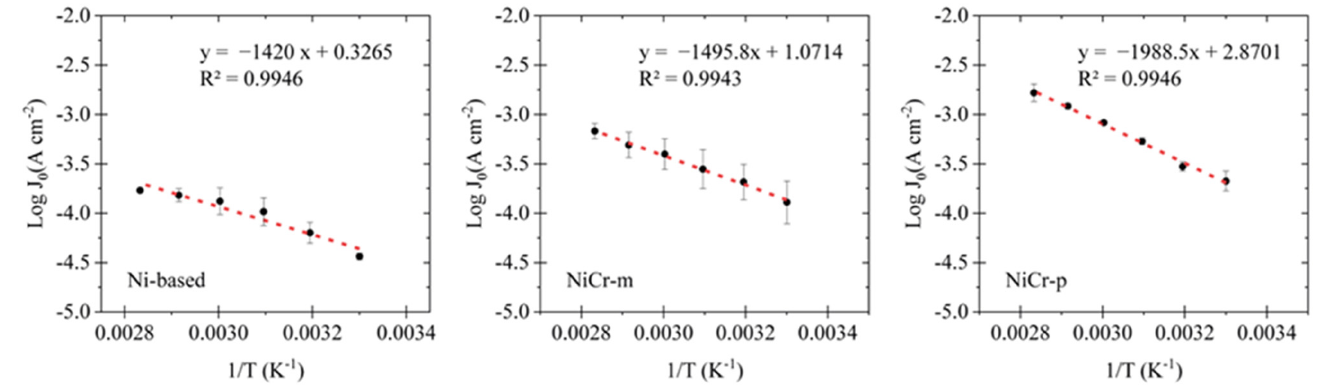
Figure 5. Arrhenius plots of the electrodes (Ni-based, NiCr-m, and NiCr-p) at the equilibrium. Table 1. Activation energy values are calculated at equilibrium.